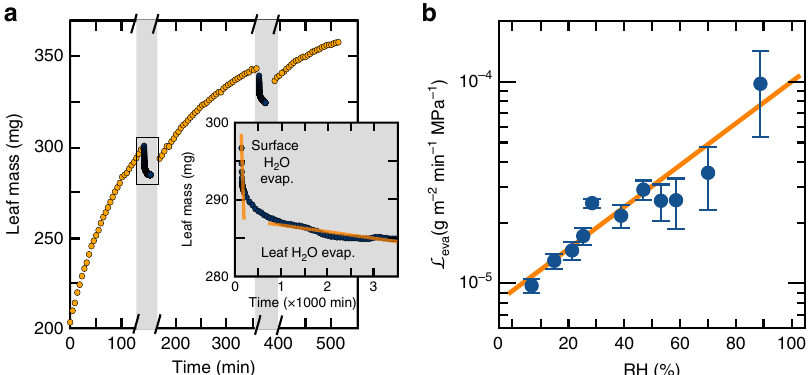
Fig. 2 Water transport asymmetry in Tillandsia aeranthos . a Water absorption and evaporation by a T. aeranthos leaf (dry weight = 61 mg, surface area = 10.4 cm 2 ). The absorption time corresponds to the cumulative time spent immersed in water. Inset: zoom on the evaporation. After a short phase (less then 30 min) of quick evaporation of the free surface water, the mass loss by evaporation reaches a nearly constant rate corresponding the water loss from the leaf's mesophyll. b Overall conductance ( L eva ) of the T. aeranthos leaf as a function of the relative humidity (RH). The data points are shown as mean ± relative error ( n > 10) and are fi tted with an